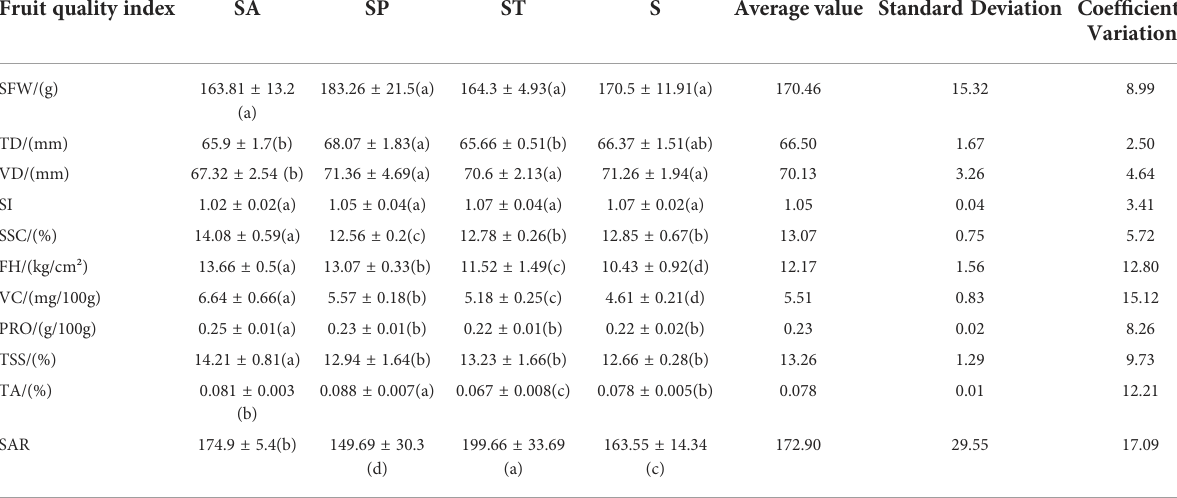
TABLE 3 Signi fi cance analysis of fruit quality indicators under four planting modes of green manures. Fruit quality